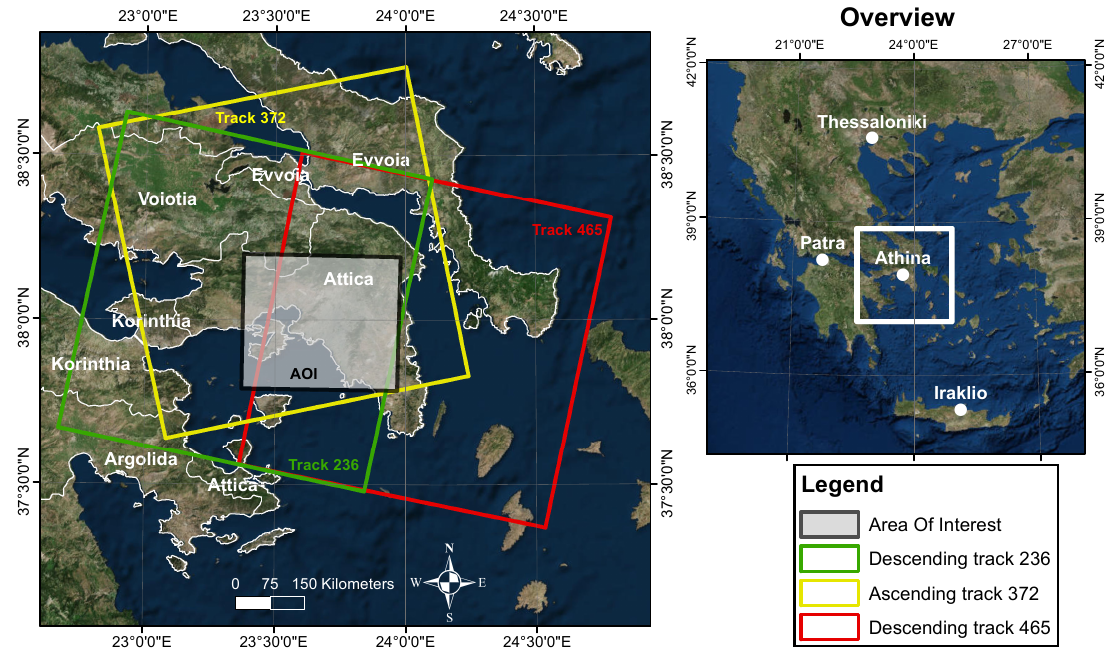
Figure 1. Location of the area of interest, the Athens metropolitan study area in Greece, and the corresponding footprints of the two adjacent descending and the one ascending satellite tracks. The same tracks were used for both ERS and Envisat datasets. Attica prefecture is also shown on this reference